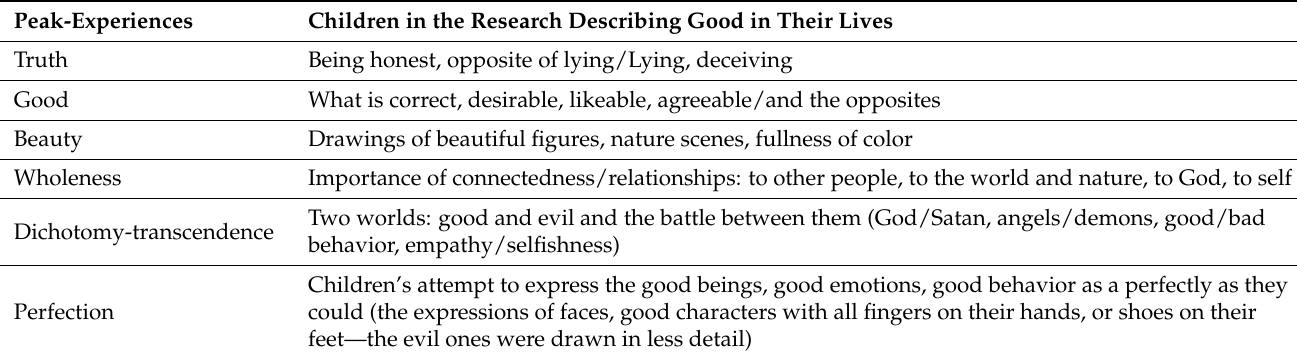
Table 8. Characteristics of Maslow’s peak-experiences vs. children’s concepts of good.